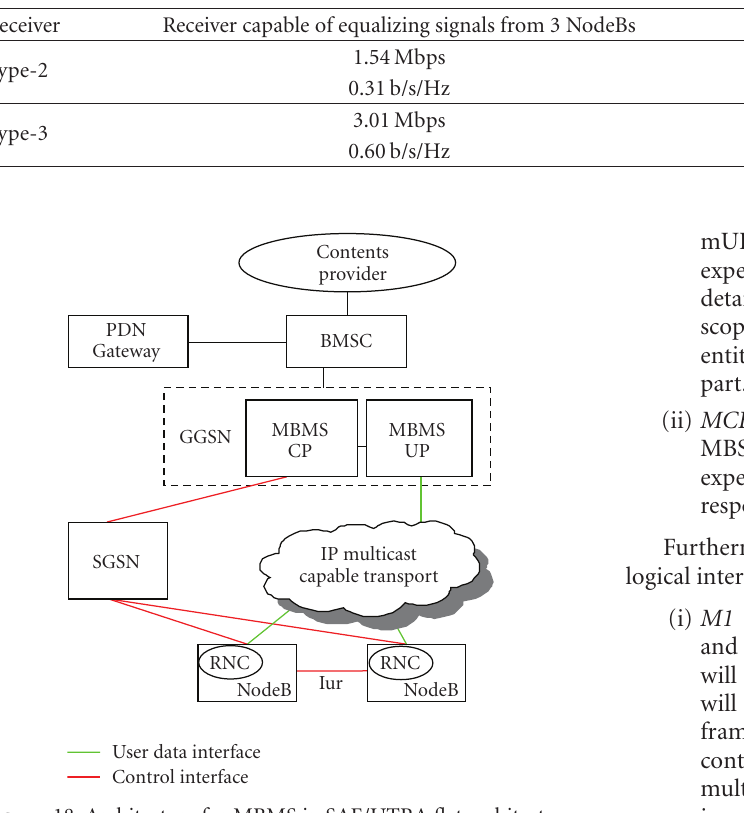
Table 4: MBMS capacity and spectrum e ffi ciency achieved by SFN operation (using 90% of the cell power) for receivers of Type-2